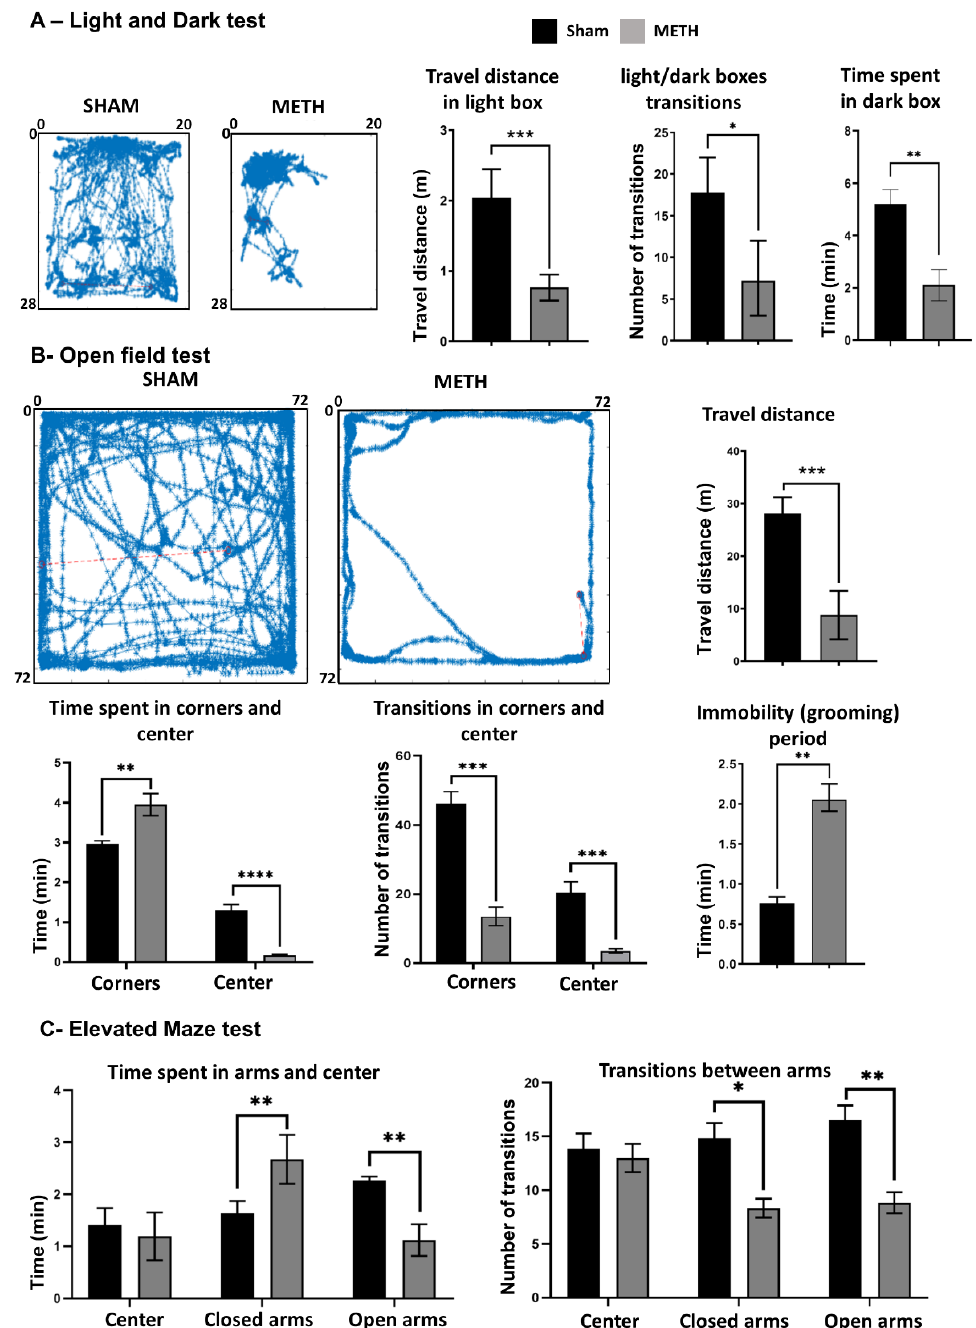
Figure 9. Acute METH exposure induces anxiety. ( A ) Anxiety test, light, and dark test (LDT) results include exploration map in the lightbox, Travel distance in the lightbox (m), Light/dark boxes transitions, and time spent in the dark box; ( B ) Anxiety test, open field test (OFT) results including exploration map in the arena, Travel distance in the arena (m), time spent in corners and center, transition in corners and center, and immobility (grooming) period; ( C ) Anxiety test, elevated maze test (EMT) results including time spent in open and closed arms, and transition between open and closed arms. Results are expressed as mean ± standard error of the mean (SEM). * p < 0.05, ** p < 0.01, *** 0.001 < p < 0.01, **** p < 0.001. for each group. Results show that the METH-treated group spent more time (2.7 ± 1.1 min) in the closed arms compared to sham-treated (2.1 ± 0.6 min) and less time (1.2 ± 0.5 min)